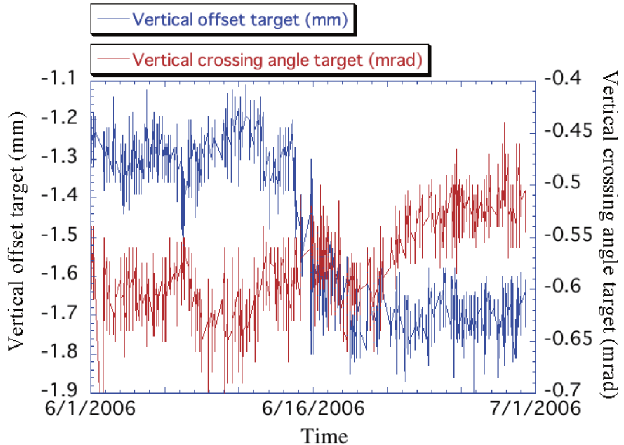
FIG. 8. (Color) History of change of the feedback target values.